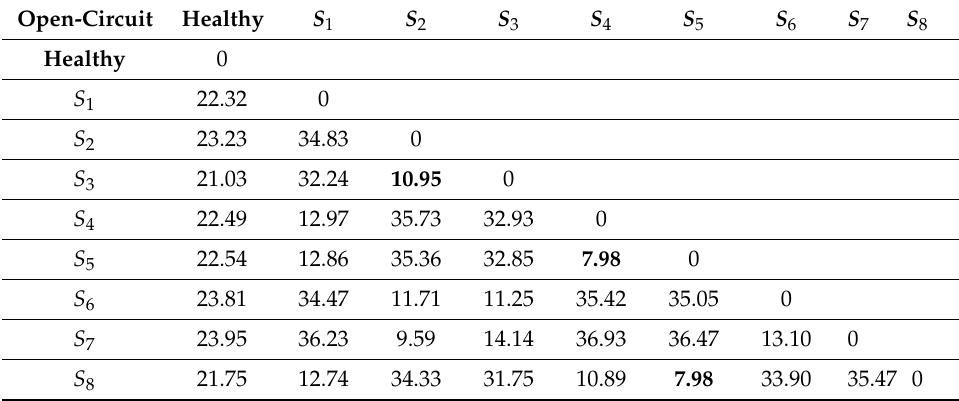
Table 5. Euclidean distance for every two faults over period T 2 under E 1 .